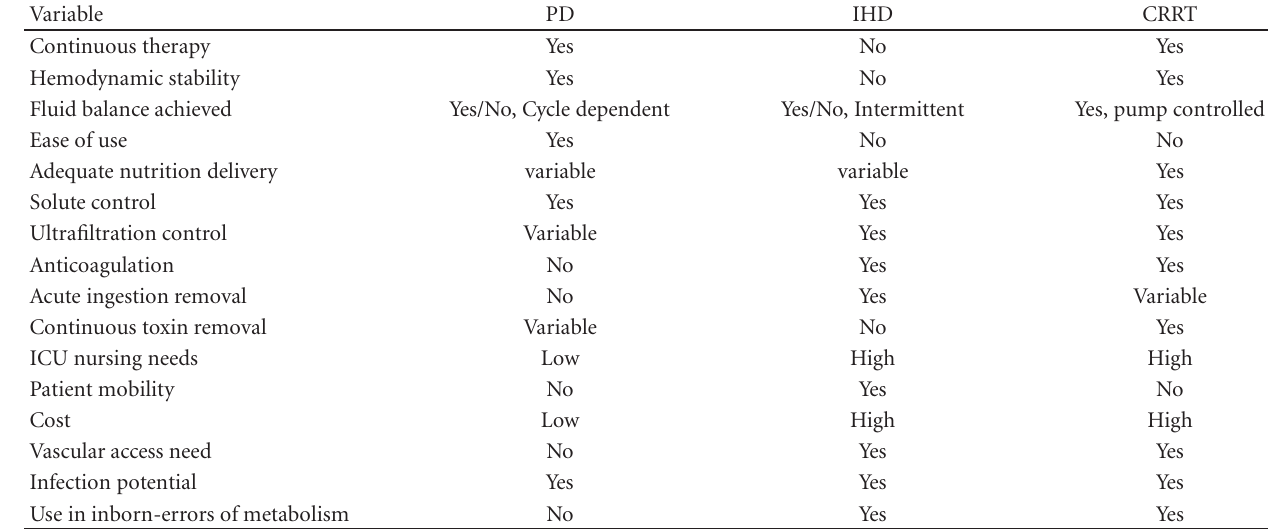
Table 1: Comparison of peritoneal dialysis (PD), intermittent hemodialysis (IHD), and continuous renal replacement therapies (CRRT). Variable PD Continuous therapy Hemodynamic